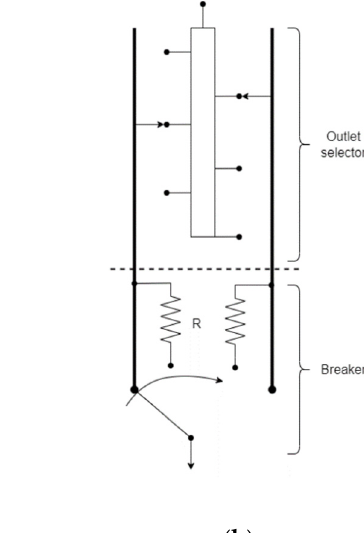
Figure 8. Thermographic photographs of overheating bushings [31].